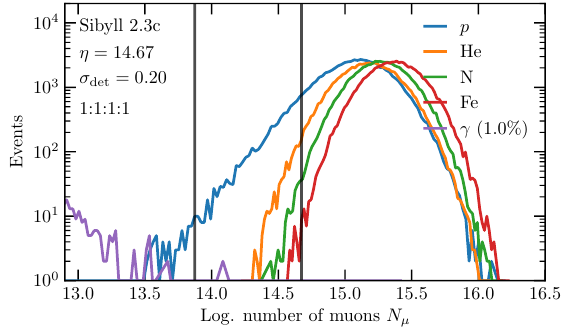
Figure 8. Expected resolution on the slope of the muon distribu- tion as a function of the number of events. Detector resolution is 20%. The primary composition is an equal mixture of proton, he- lium, nitrogen and iron. The band around the curve indicates the spread of 68% of independent realizations of experiments with the given number of events around the